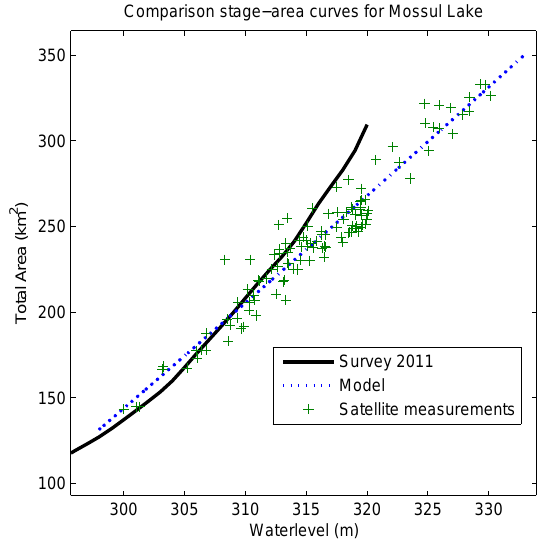
Figure 3. Linear regression stage–area curve for lake Mosul. The curve is compared with a survey in 2011 using sonar by Issa et al. (2013).